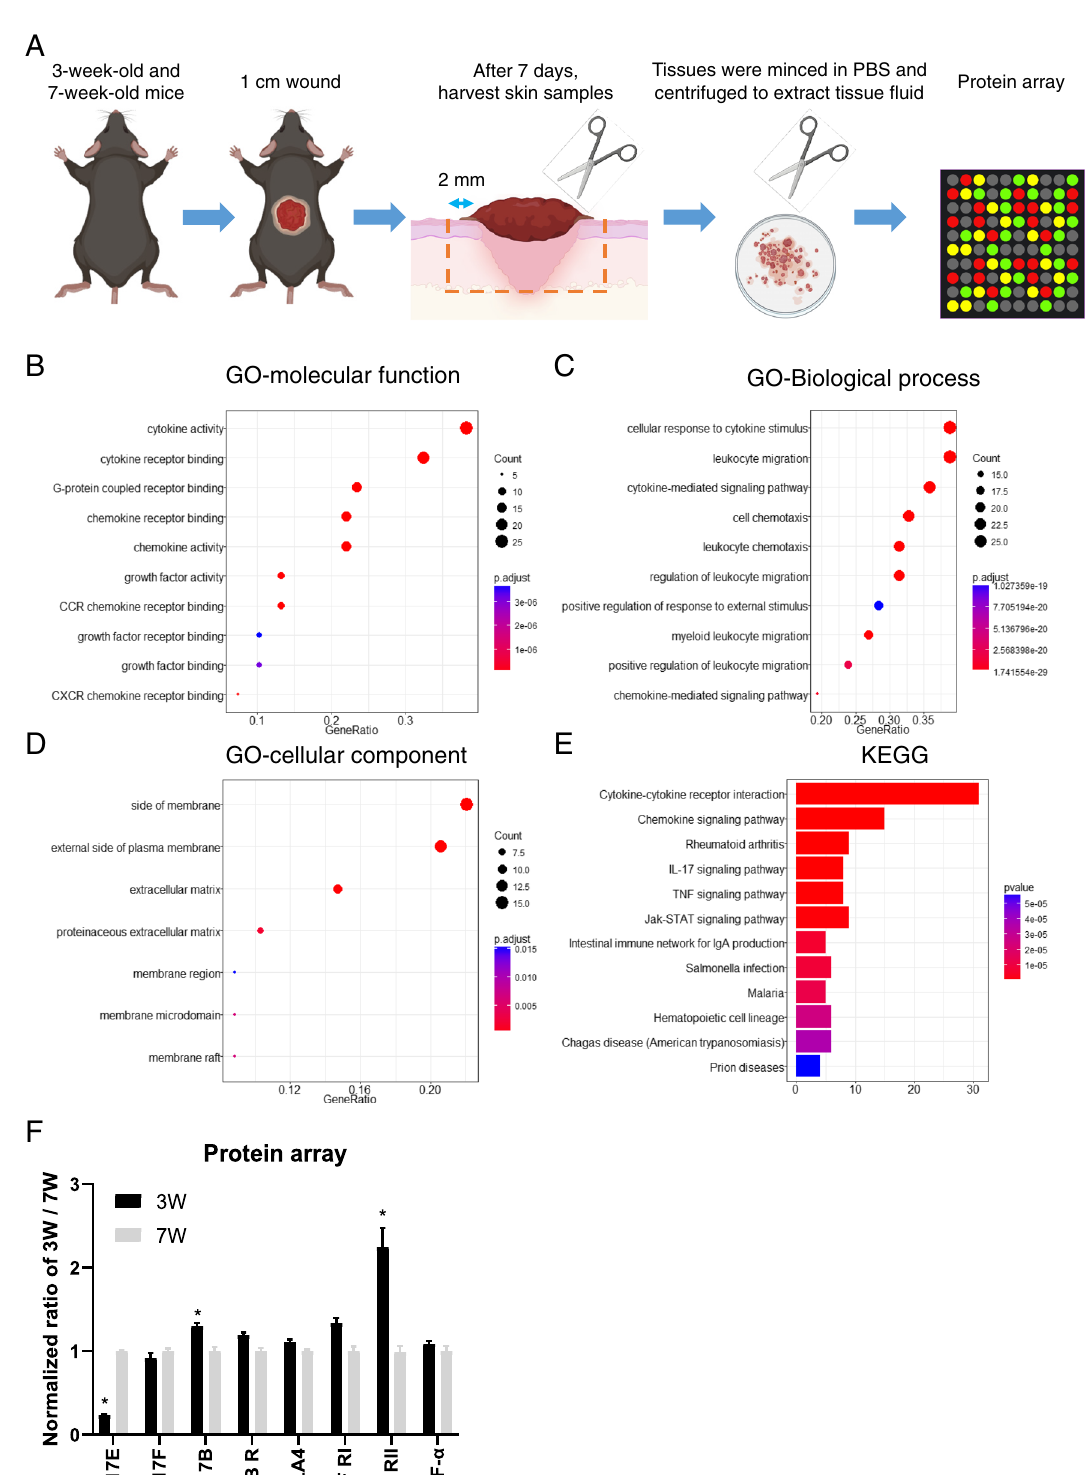
Fig. 2 The biological differences between 3 and 7W mice in wound healing. A Experimental steps. B , C , D GO analysis of protein array in molecular function, biological process, and cellular component. E KEGG analysis of protein array. F Normalized expression levels of IL-17 family, regulatory T cells biomarker CTLA4 and TNF family. * P <